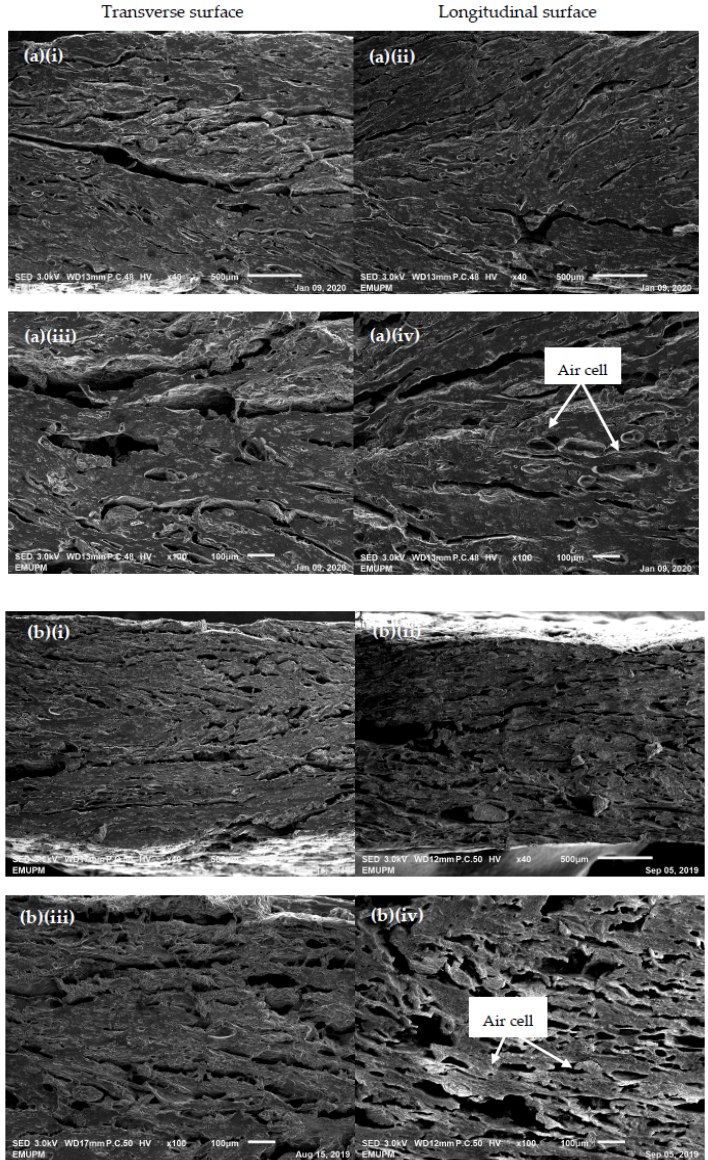
Figure 4. SEM images of raw extrudates without oyster mushroom ( a : i – iv ) and with 15% oyster mushroom ( b : i – iv ) produced at 160 rpm screw speed: transverse and longitudinal surfaces.